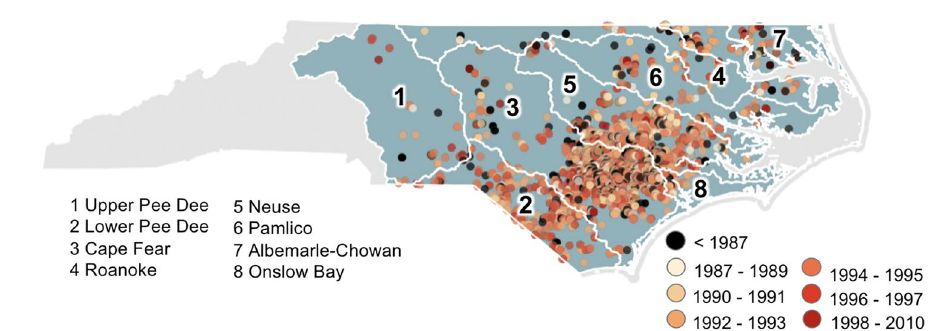
Figure 6. Spatiotemporal distribution of swine waste lagoon construction (+/- 1 year) across the HUC6 watersheds. This figure was produced using QGIS version QGIS 3.18.3 (https:// www. qgis.